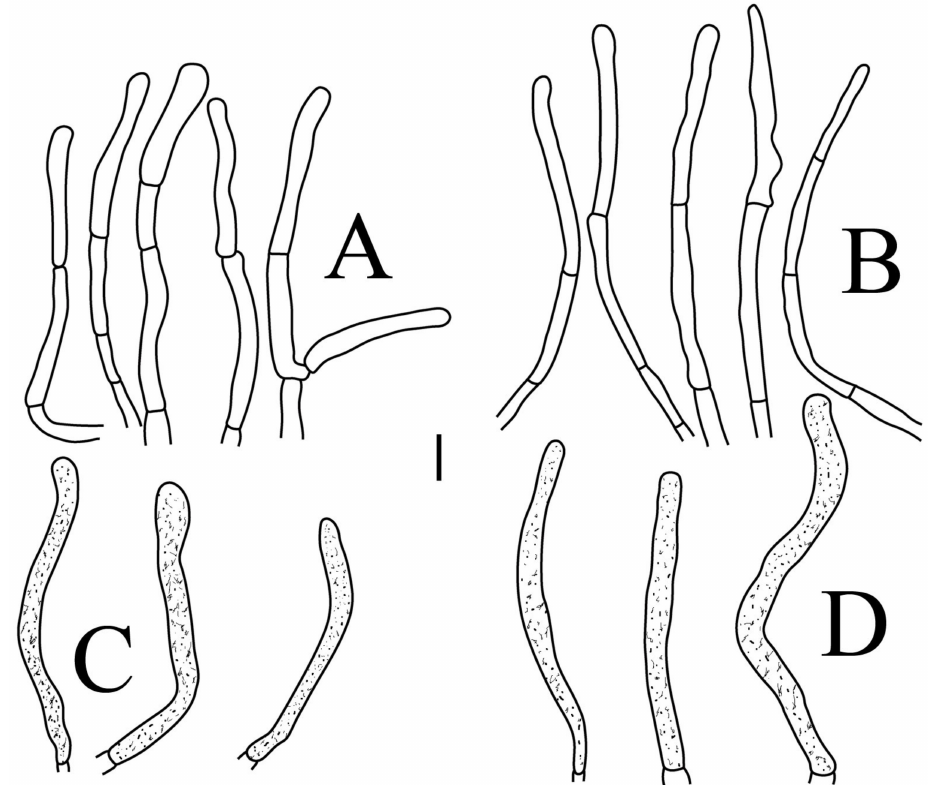
Figure 9. Russula longicollis (RITF5685, holotype): ( A ) hyphal terminations near the pileus margin; ( B ) hyphal terminations near the pileus center; ( C ) pileocystidia near the pileus margin; ( D ) pileocys- tidia near the pileus center. Scale bars: 10 µ